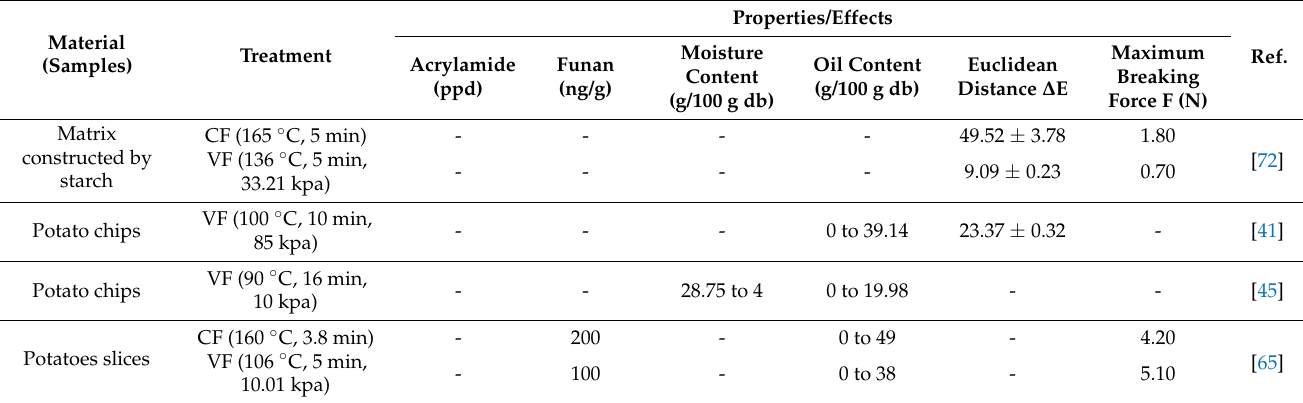
Table 3. Effects of vacuum frying on different